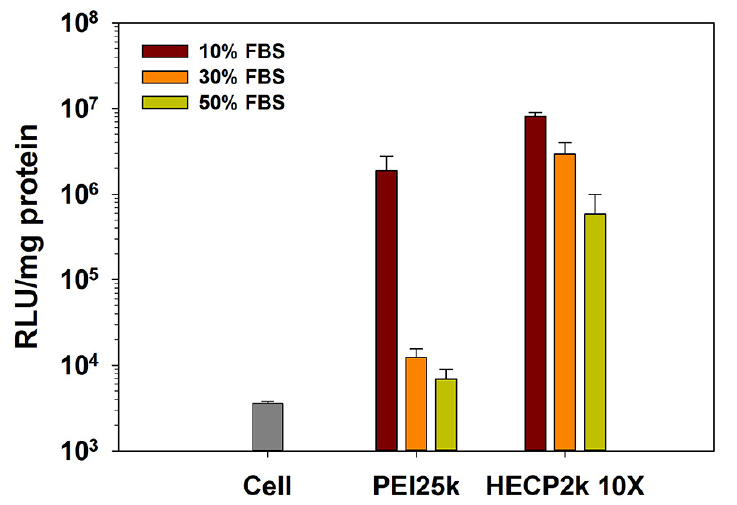
Figure 7. Serum stability test results of HECP2k 10X polyplexes (wr = 50) via luciferase assay. PEI25k polyplexes (wr = 1) were used as control.